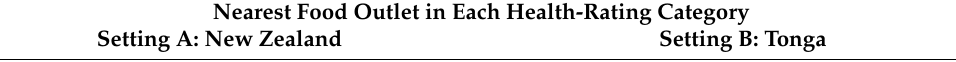
Table 5. Distance from the school to the nearest food-outlet by